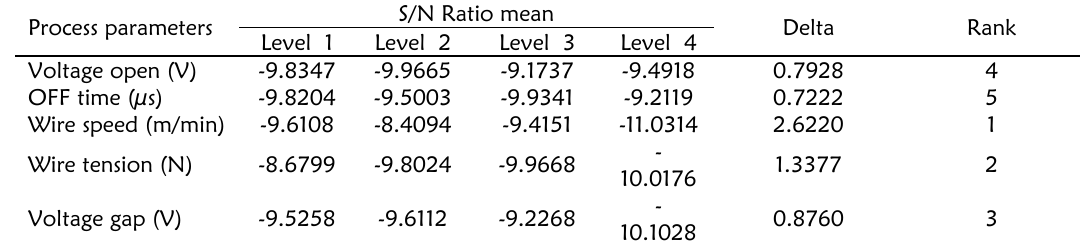
Table 3: S/N ratio means for R